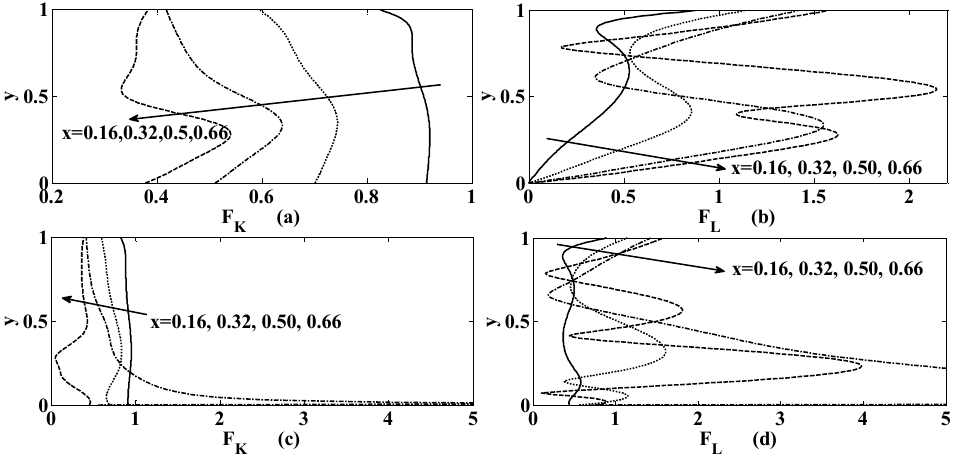
F ( b ), ( d ) the Lorentz force F , at Figure 12. Variation of magnetic forces ( a ), ( c ) the Kelvin force F K ( b ), ( d ) the Lorentz force F L , at the (cid:8) (cid:9) = { K L S t , R , γ 0.001, 10, 1 } for ( a ),